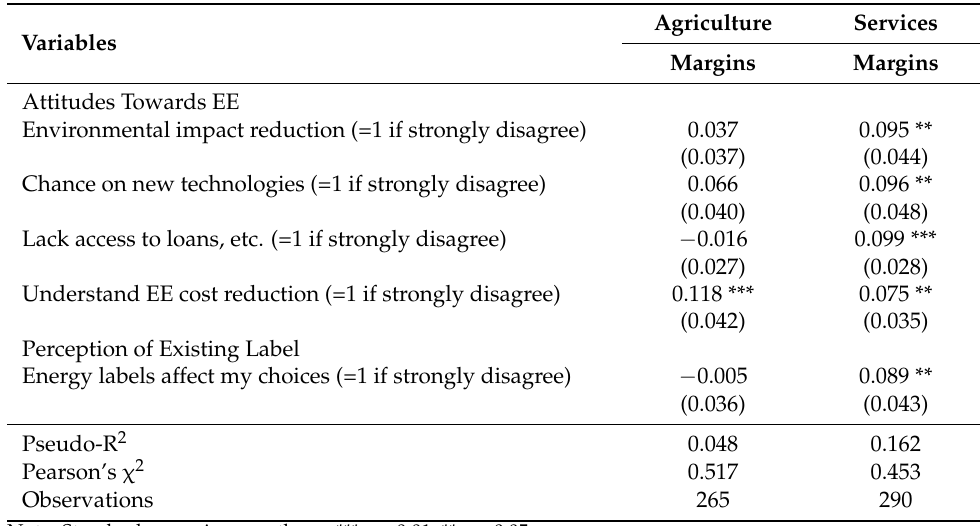
Table 16. Variables affecting firms’ perceptions of energy efficiency—probit marginal effects (sec- toral